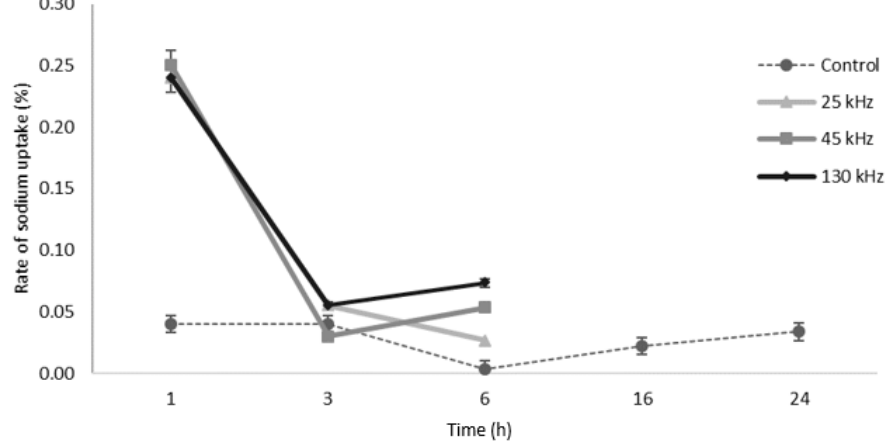
Figure 1. Rate of sodium uptake based on treatment time. Sodium uptake (g / 100 g of sample) in chicken samples marinated with 8% NaCl solution in an ultrasonic bath (25, 45, 130 kHz) or by immersion (Control). The rate at each time interval was calculated as ((Na) T2 − (Na) T1 ) / (T 2 − T 1 ). Cooking loss values of control and US-marinated samples are also presented in Table